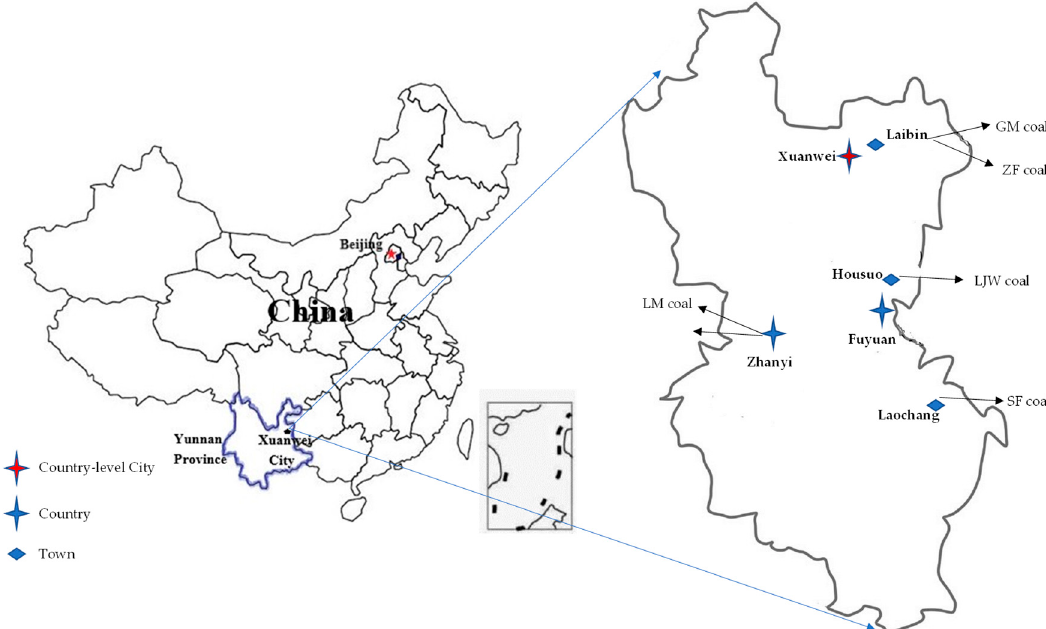
Figure 2. Sampling sites (Bole coal (BL), Luomu coal (LM), Shunfa coal (SF), Lijiawu coal (LJW), Guangming coal (GM), and Zongfan coal (ZF)).